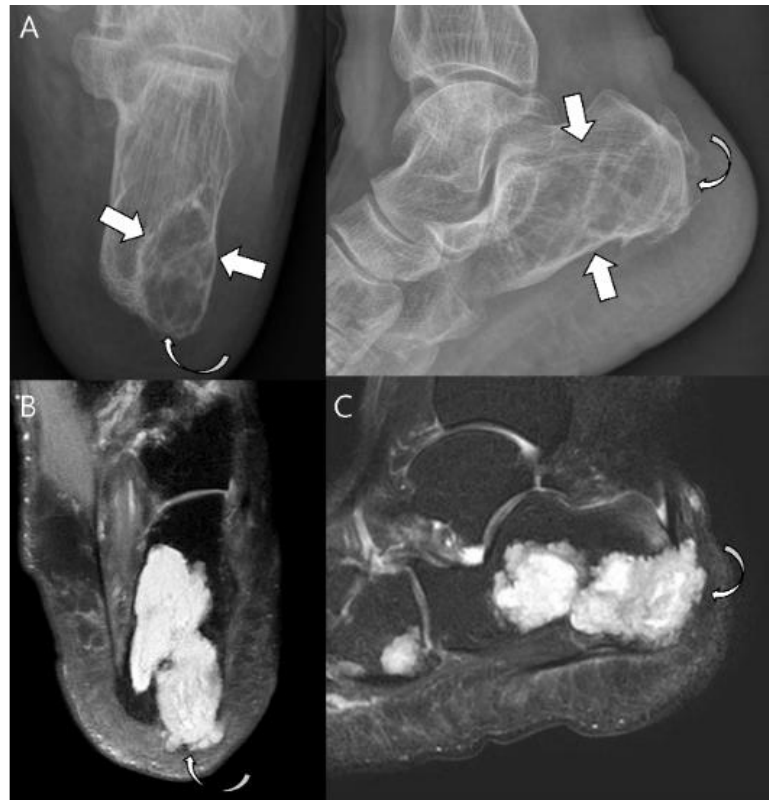
Figure 6. Atypical cartilaginous tumor of the calcaneus in a 74-year-old woman. ( A ) Plain radio- graphs reveal a lytic lesion in the calcaneus (arrows) with a partially destructed cortex (curved arrow). ( B ) Axial and ( C ) sagittal T2-weighted images with fat suppression show a lesion with marked high-signal intensity with focal extraosseous soft tissue extension (curved arrows).